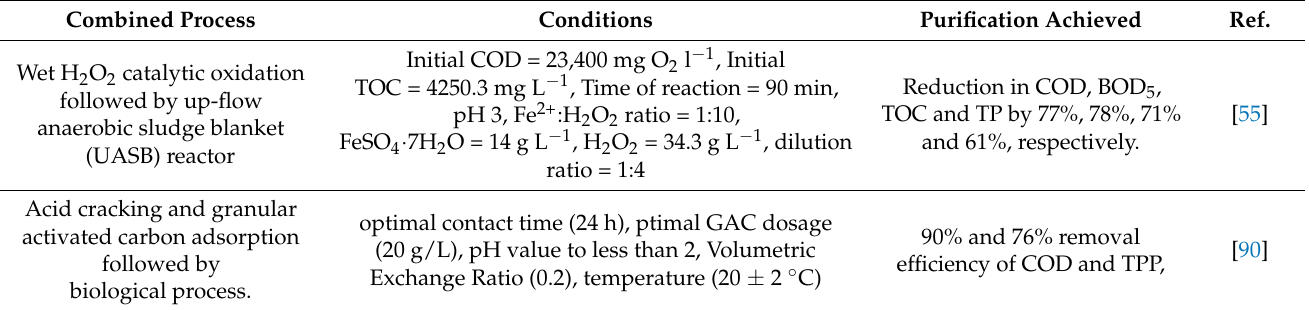
Table 6. A summary of some recent combined treatment methods and their achieved level of purification. Combined Process Conditions Purification